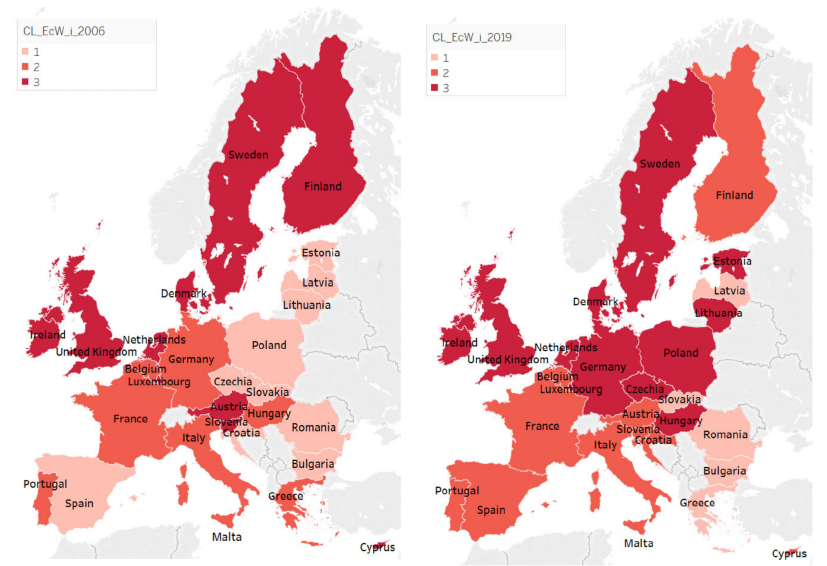
Figure 4. Representation of clusters regarding economic wellbeing components in 2006 vs. 2019. Source: SSI database, computed in Tableau Public v.